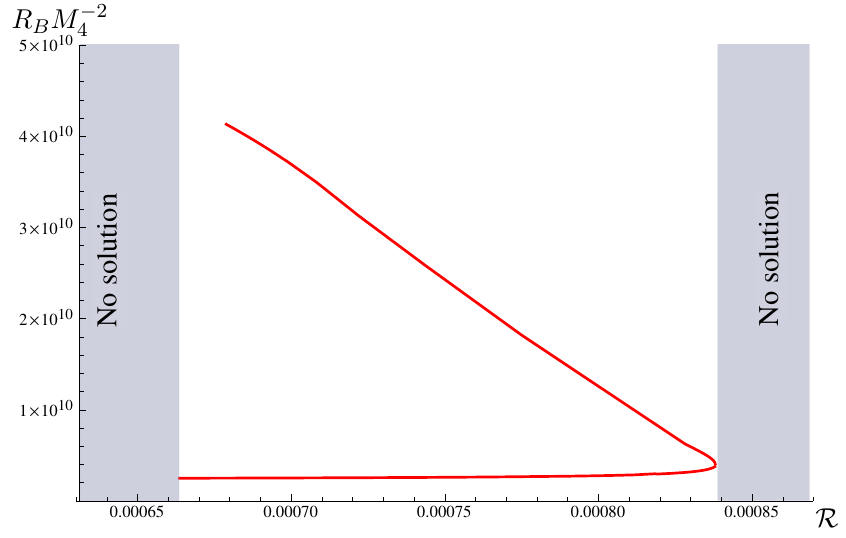
p vs. R for b = 1 : 1 (cid:2) 2 = 3. Results are obtained for bulk 4